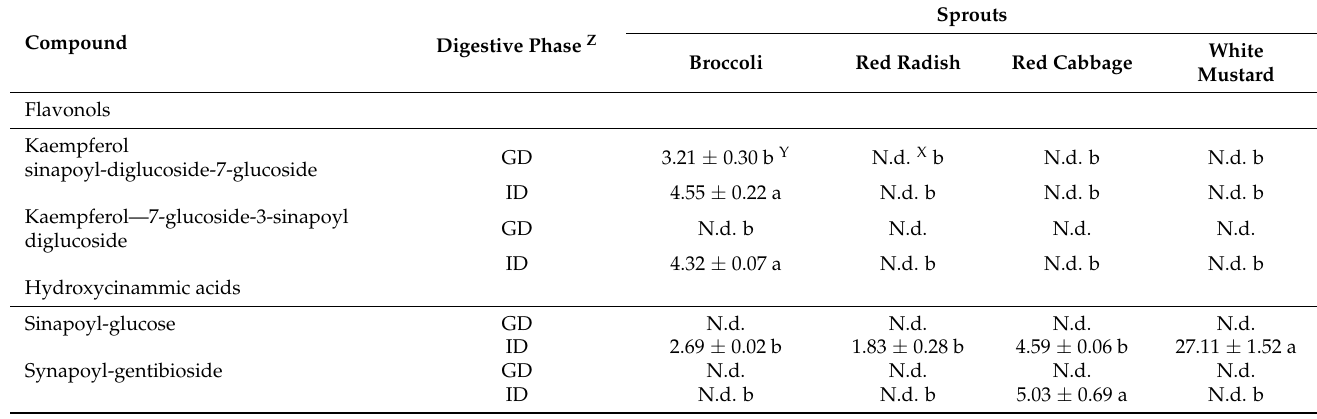
Table 5. Quantitative profile (mg/100 g fw) of individual flavonols and hydroxycinnamic acids of the gastric and intestinal digested plant material.